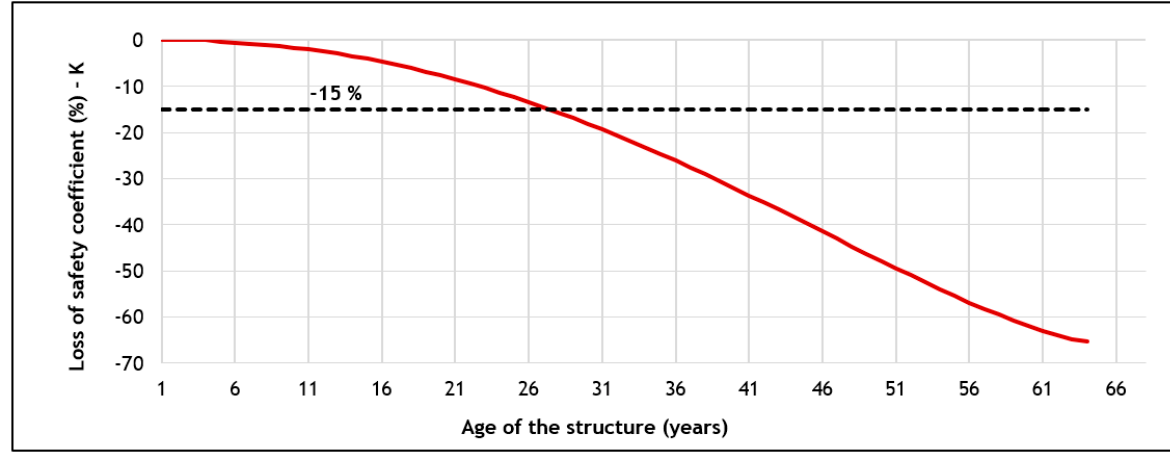
Figure 8. Estimation of the loss of strength capacity over its service life of a structural element working on single flexure with corrosion problems in its main reinforcement.